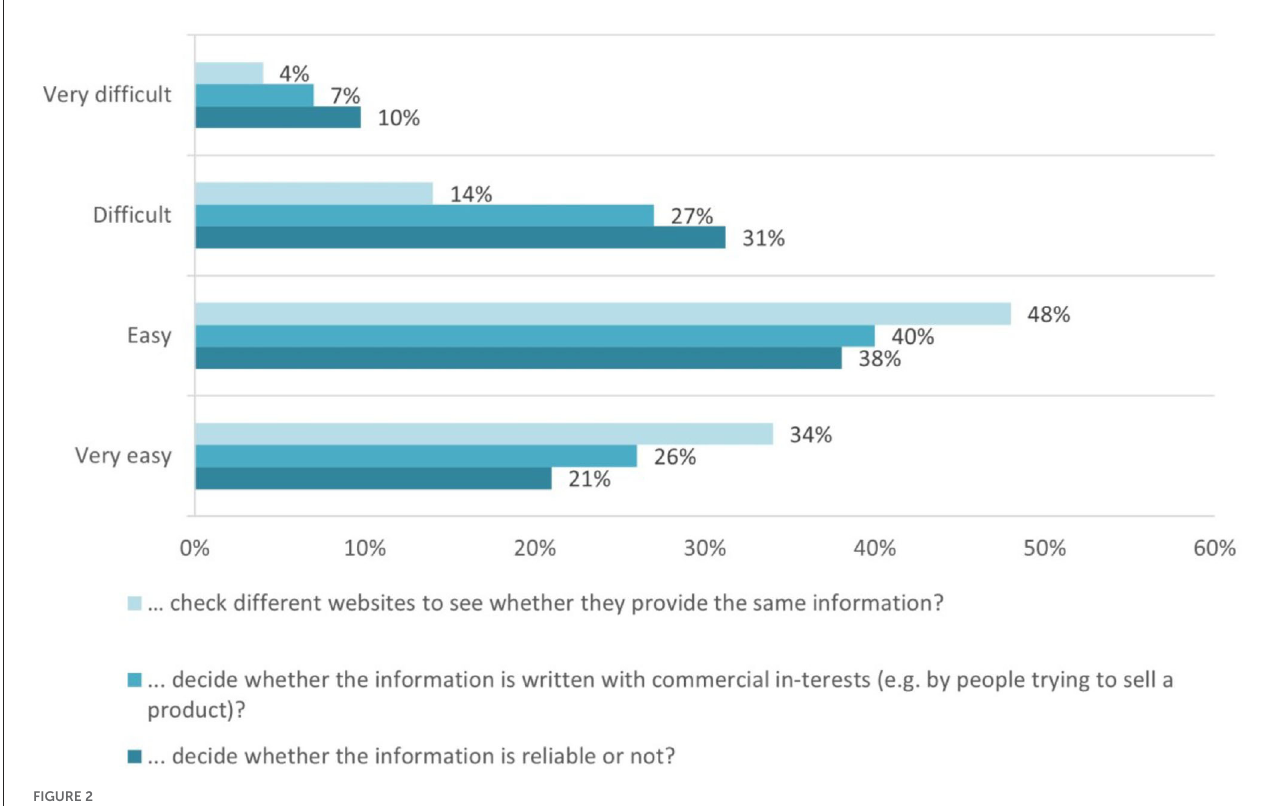
FIGURE2 Means the students used to appraise health